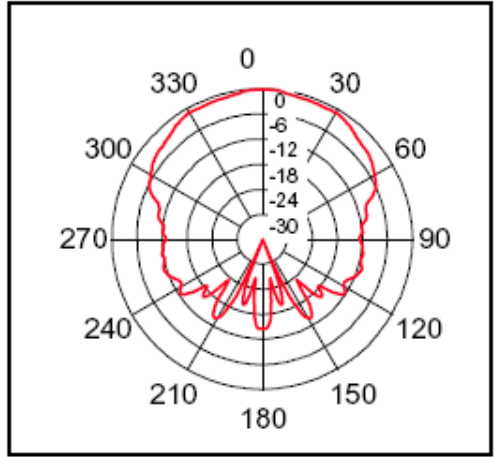
Figure 17 . Receiver beam